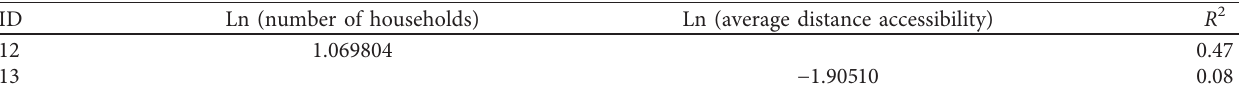
Table 8: Values of calibrated parameters for equation (3): model specifications with transformed variables.